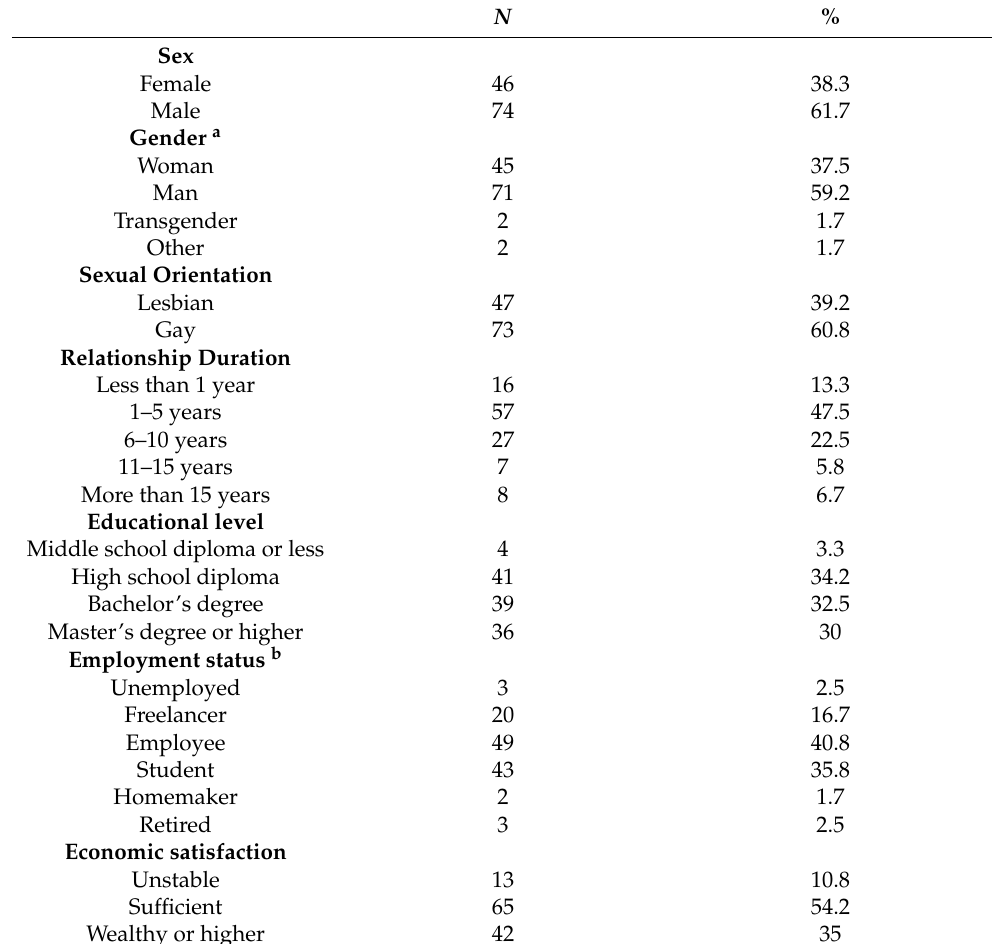
Table 1. Characteristics of the